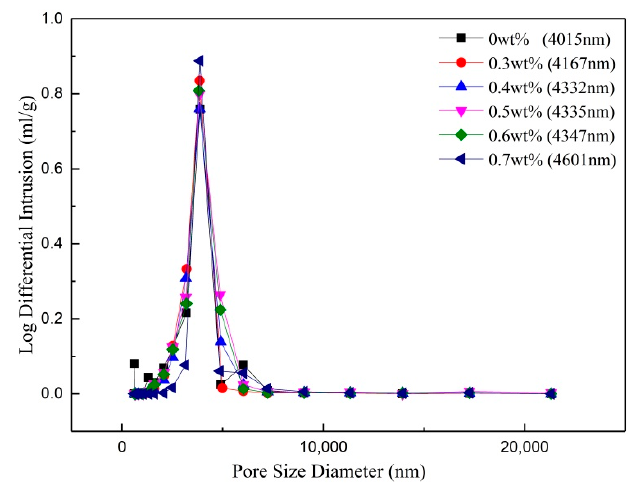
Figure 8. Pore size distribution of the supports with different contents of TiO 2 added by in-situ hydrolysis method.